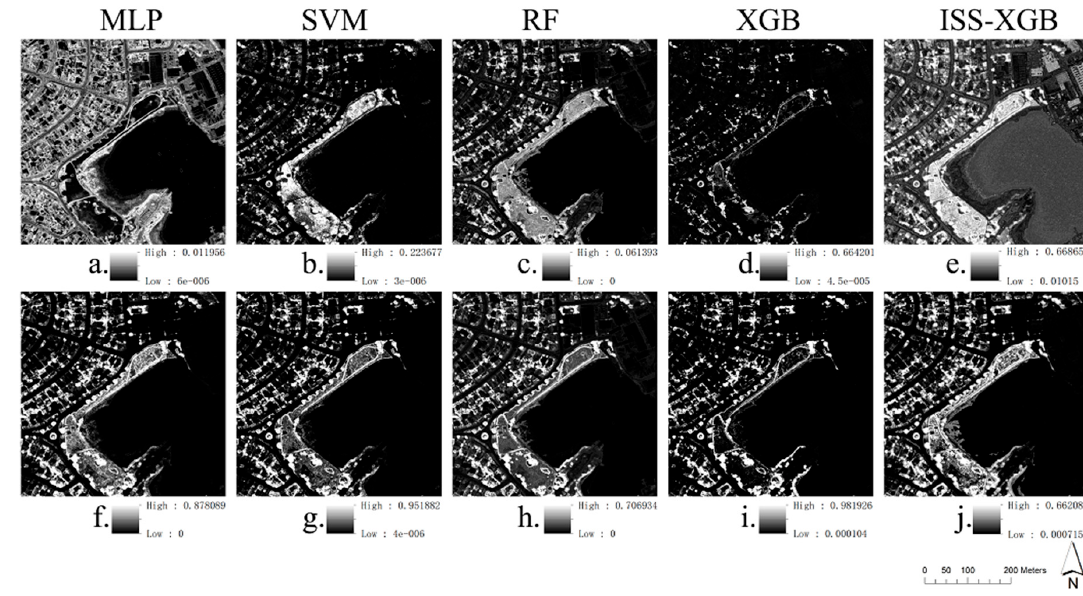
Figure 3. Predicted probability maps of the minority class (tree) of Area 8 with di ff erent imbalanced samples (minority:majority = 2:98; minority:majority = 50:50). Sub-figure ( a – e ) shows the predicted probability map by di ff erent methods with a sample ratio at 2:98 (( a ): MLP; ( b ): SVM; ( c ): RF; ( d ): XGB; ( e ): ISS-XGB). Sub-figure ( f – j ) shows the predicted probability map by di ff erent methods with a sample ratio at 50:50 (( f ): MLP; ( g ): SVM; ( h ): RF; ( i ): XGB; ( j ):